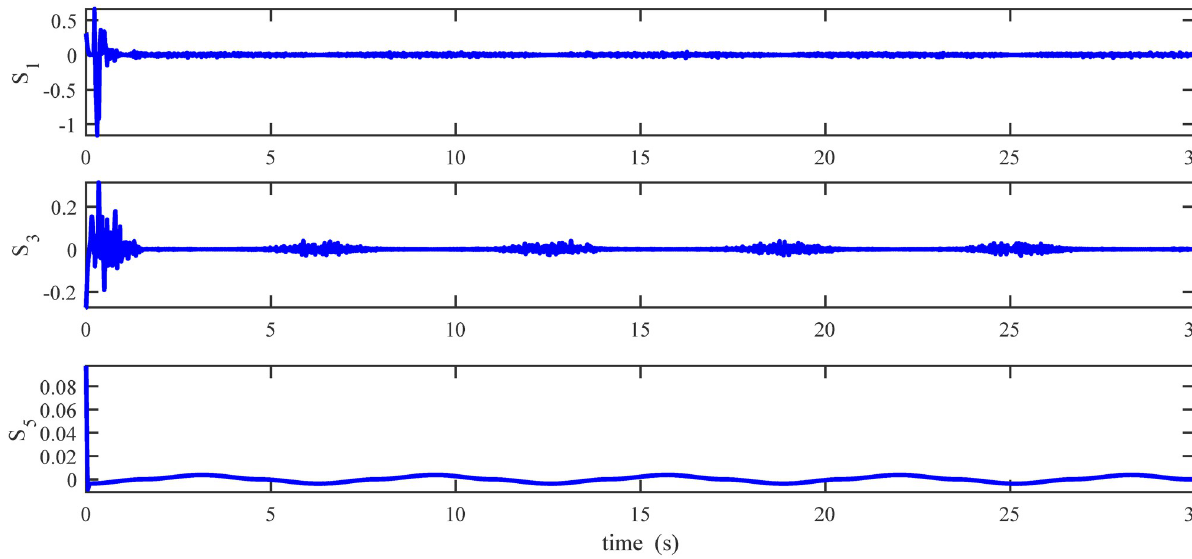
Fig 17. Results of the attitude sliding variables under the proposed